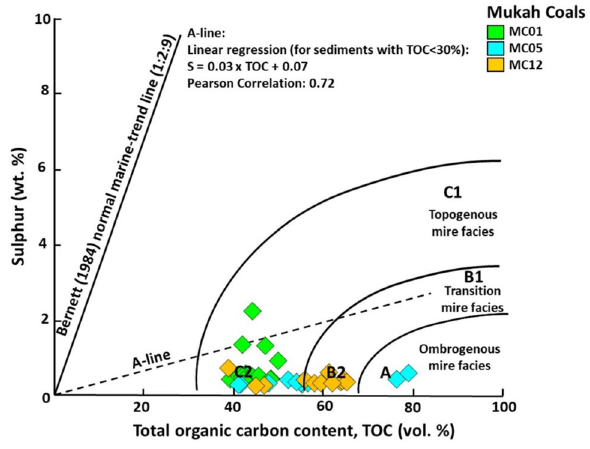
Figure 12. A plot of sulfur (wt%) versus TOC (wt%) for the analyzed Mukah coals (after Jasper et al., 2010) shows the peat development within topogenous to ombrogenous mire